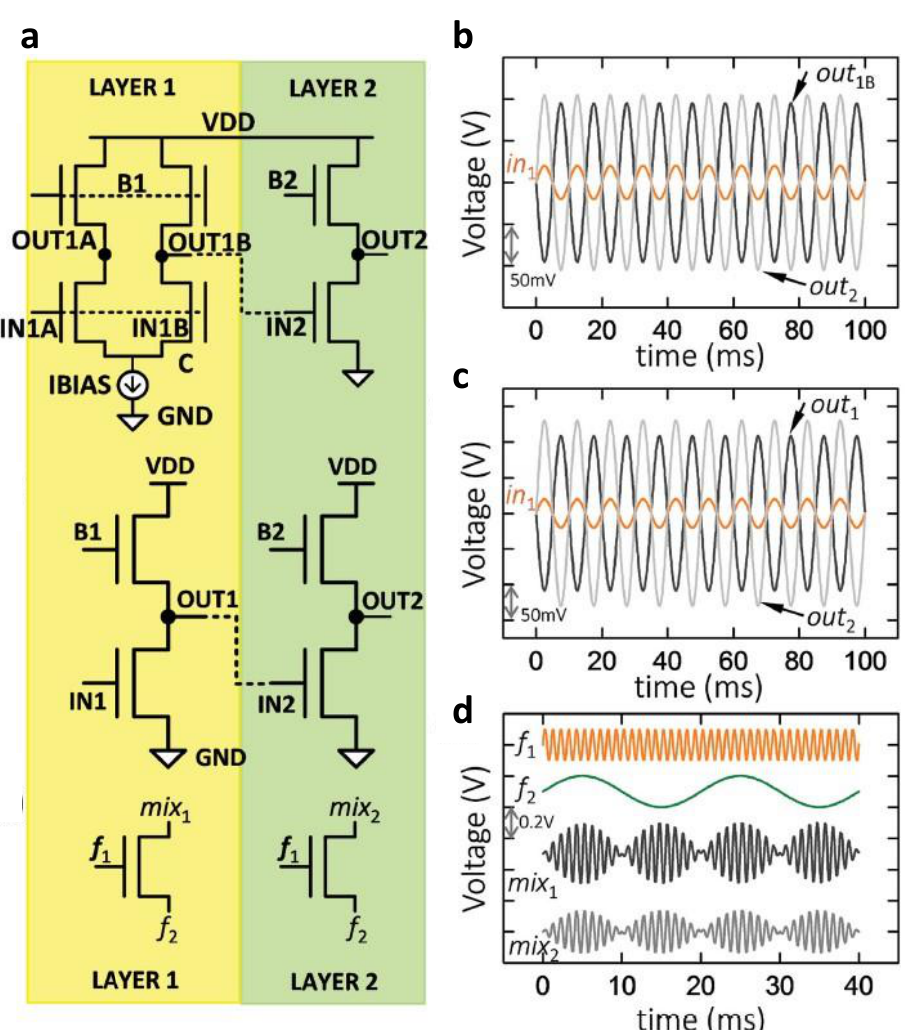
Figure 10. TMD-based thin-film analog circuits. ( a ) Circuit schematics of the differential amplifier, common source amplifier, and signal mixer composed of MoS 2 and WSe 2 TFTs, and ( b – d ) input/output characteristics corresponding to each circuit (adapted from [ 84 ] with permission from John Wiley and Sons).